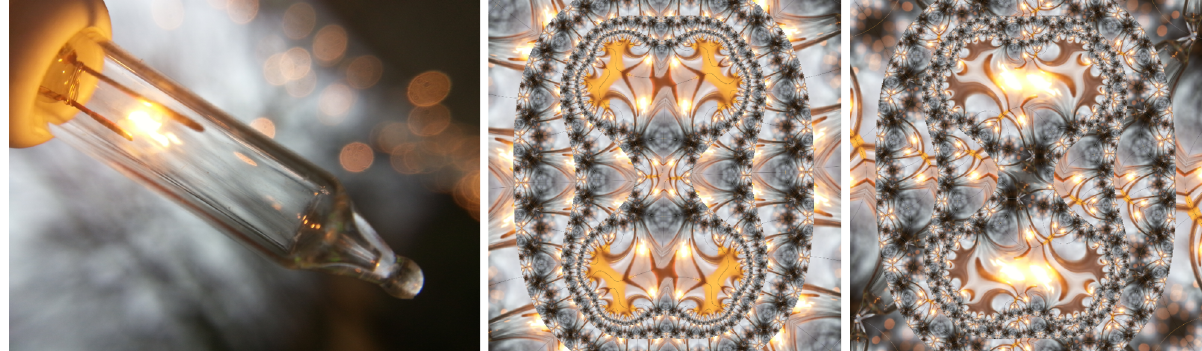
Figure 1 | Source photograph (left), photo embedded into a Julia set (center), another embedding with a different transformation matrix, M